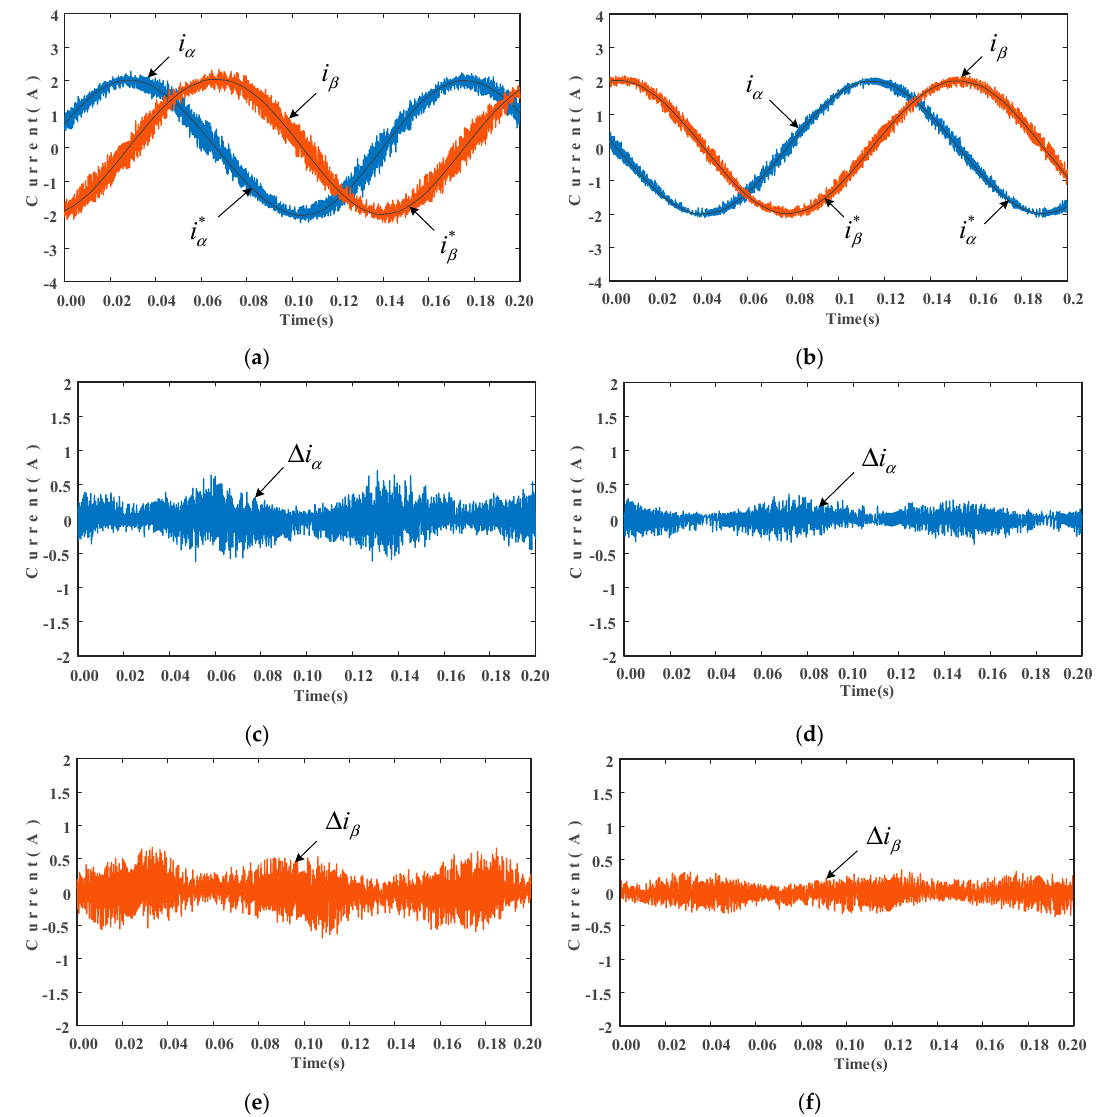
Figure 15. Currents and current errors under constant speed of 200 rpm and load-torque 1 N-m: ( a ) current responses of the MPCC without modulation, ( b ) current responses of the proposed MMPCC, ( c ) the α -axis current error of Figure 15a, ( d ) the α -axis current error of Figure 15b, ( e ) the 𝛽 -axis current error of Figure 15a, and ( f ) the 𝛽 -axis current error of Figure 15b.